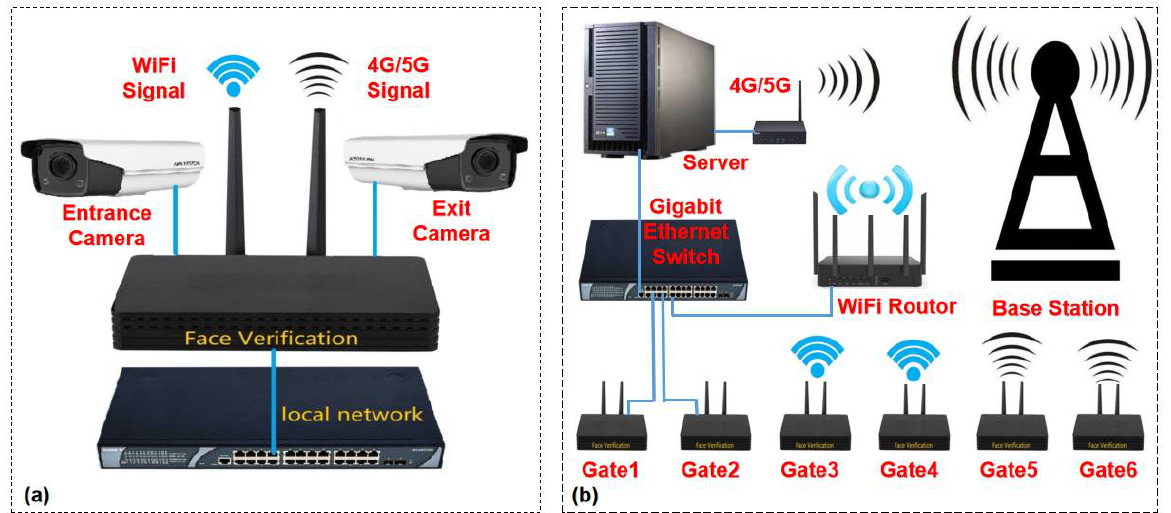
Figure 9. Personal tracking system with face verification devices. ( a ) Face verification device. ( b ) Network architecture of the prototype system.